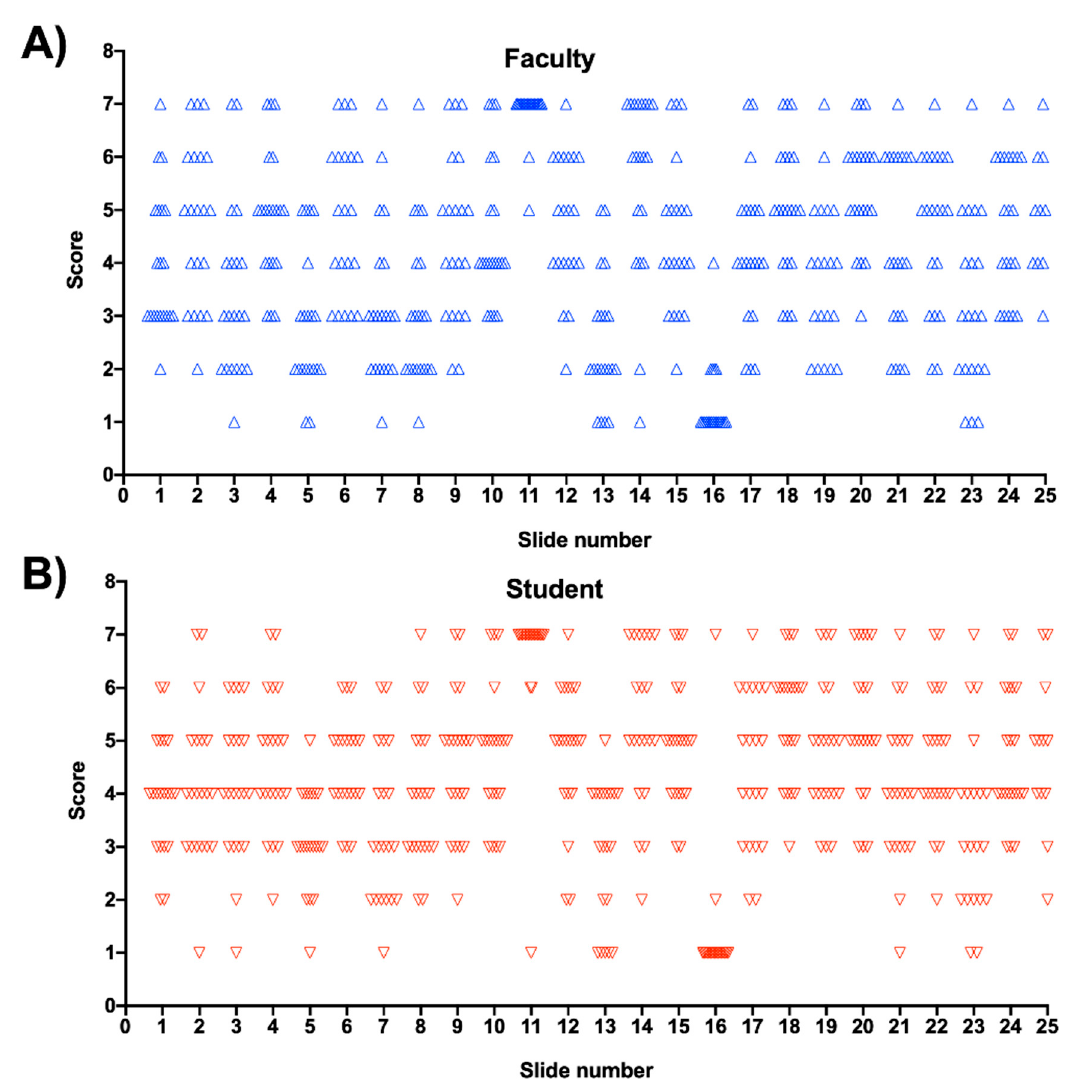
Figure 2. Scatter plot data for 7-point scale, ( A )—faculty, ( B )—students. Five digital images were repeated twice in the study, the results of comparing the repeatability of reviewing the same slide more than once in the slide show using the 3-point scale can be seen in Table 2. Final year dental students were shown to be more consistent (CPE of 0.16) than dental faculty (CPE of 1.80) when evaluating the five repeat slides ( p < 0.05). When reviewing the repeat slides more than once, using the 7-point scale, the results (as determined by the CPE) were identical as seen in Table 3, (both students and Table 1. The CPE for the 3-point scale was 0.054, while to CPE for the 7-point scale was faculty had a value of 0.669). 0.513. The parametric Pearson correlation coefficient 0.37 and non-parametric Spearman correlation coefficient 0.57, both elicited a positive relationship between the 3-point scale Table 2. Covariance parameter estimates (CPE) for 3-point group and the 7-point scale group, using the 1200 data points available. To normalize the comparison between the 3-point and the 7-point scale, the Z value is used which is the CPE/Standard Error. The Pr ˃ Z is the p value, for the probability that the CPE is signifi- cantly equal to zero, other than random variables. Table 1. Combined faculty and dental student covariance parameter estimates (CPE) for both scales.